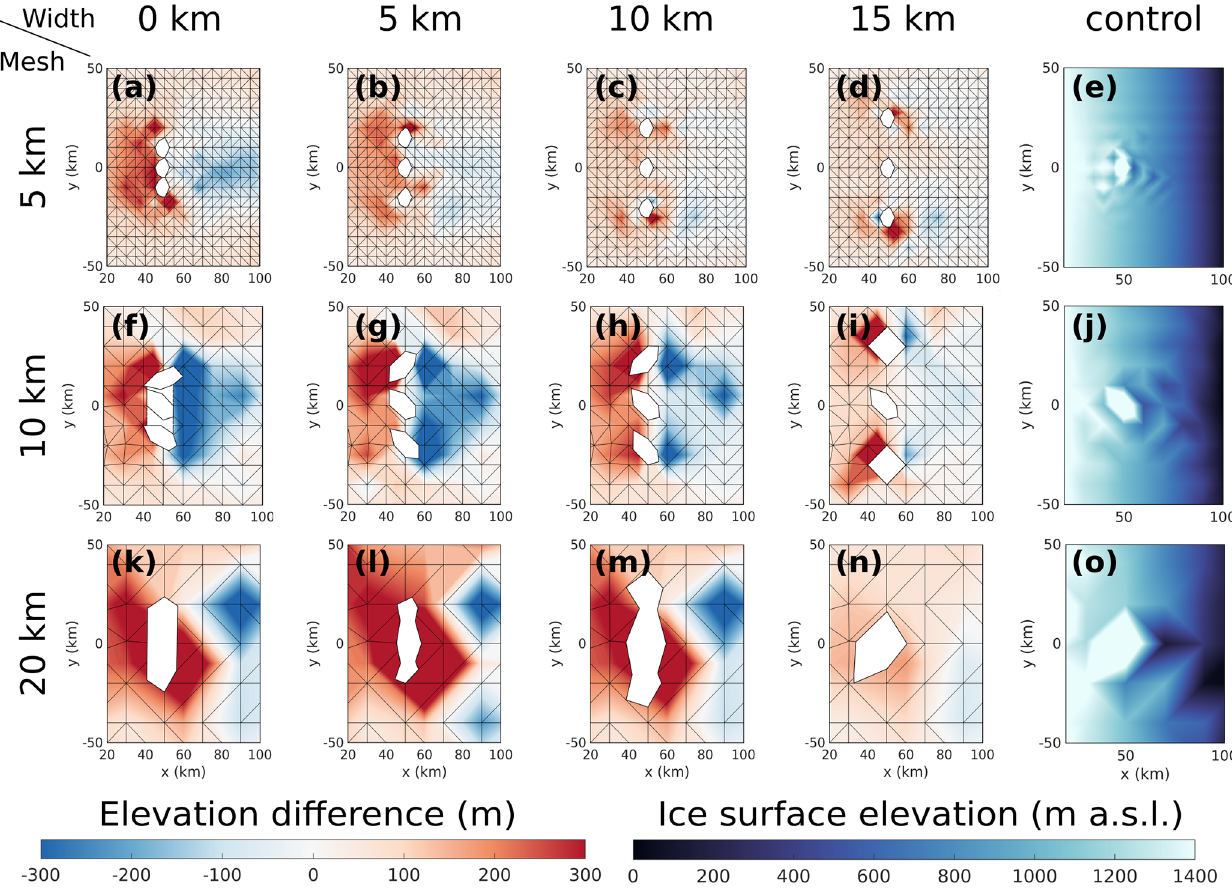
Figure 9. Difference in surface elevation (m, as in Fig. 7) between each thw three-nunatak configuration (varying glacier widths) and the thw control with one nunatak (rightmost panels), for three regular-mesh resolutions of 5, 10, and 20km. The reference experiments were also performed on a regular mesh. These panels illustrate how differential elevation changes up- and downstream of the nunataks (digitised in white based on their outcrop size, linearly interpolating the ice surface between the nodes and vertices) differ from the experiments using a refined mesh (Fig. 7) and how this mismatch decreases with increasing glacier width.